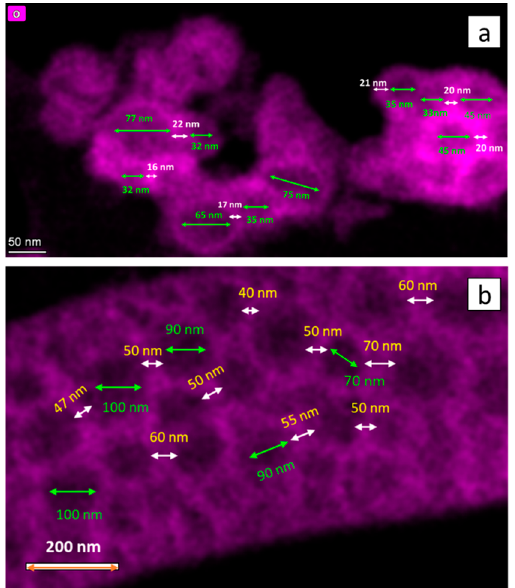
Figure 7. EDS mapped images of core/shell nanostructures. ( a ) shows OMO(5) and ( b ) illustrates OMO(40), displaying the presence of a Co oxide shell in the structure The core size is indicated by green arrows, while the shell thickness is indicated by white arrows.